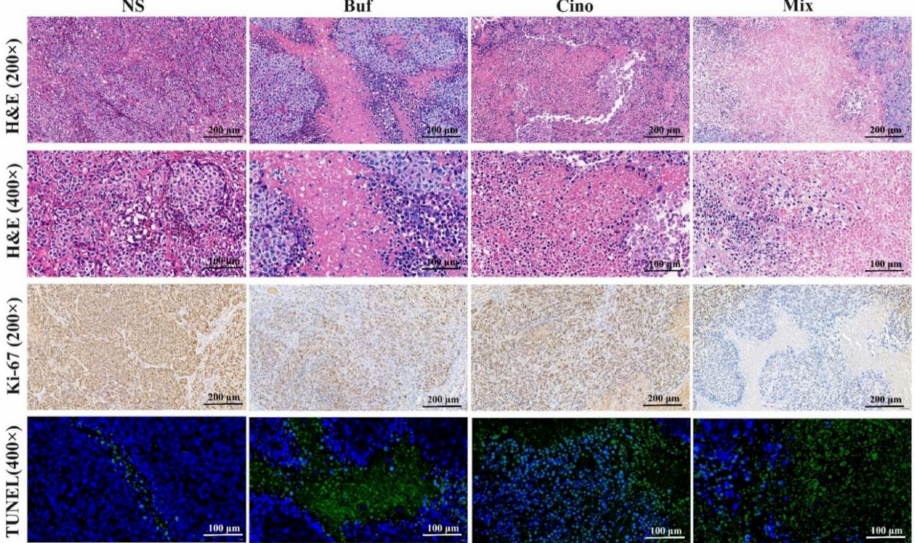
Figure 6. Pathological analysis of tumor with different treatment groups. H&E staining, pale pink areas suggest necrosis area. Ki-67 staining, Brown color represents the nucleus of vigorously proliferating cells. TUNEL staining, green fluorescence represents the nucleus of apoptotic cells. (Original magnification: 200 × and 400 ×